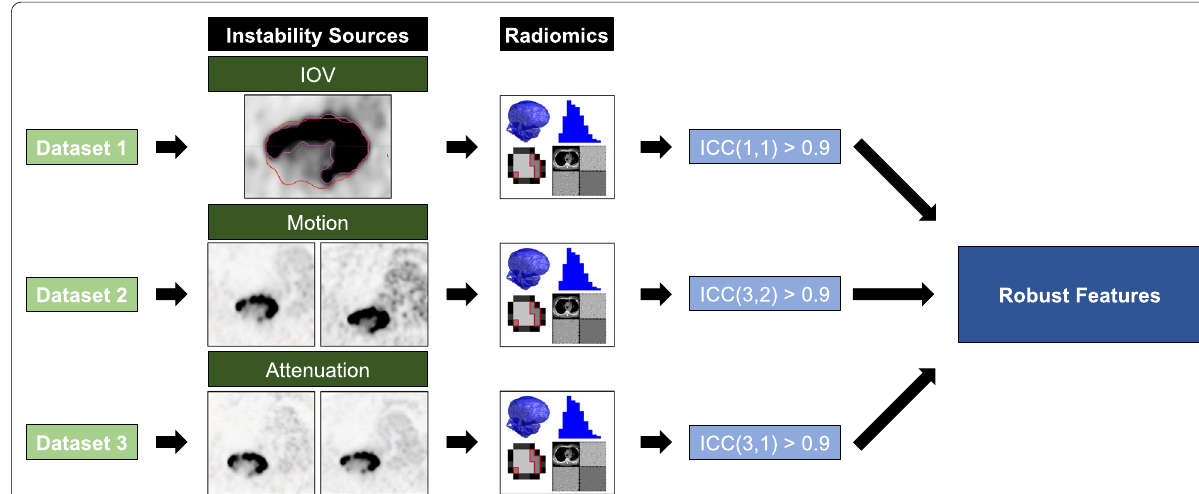
Fig. 2 Robustness studies. The influence of delineation variability or image was investigated using either a pair of scans for each patient as it is the case for the PET/CT/PET/MR and motion comparison, or different methods of defining the regions of interest (ROI), as applied for the delineation study. Radiomics calculation was performed on each individual ROI. Robust features were determined using the intraclass correlation coefficient